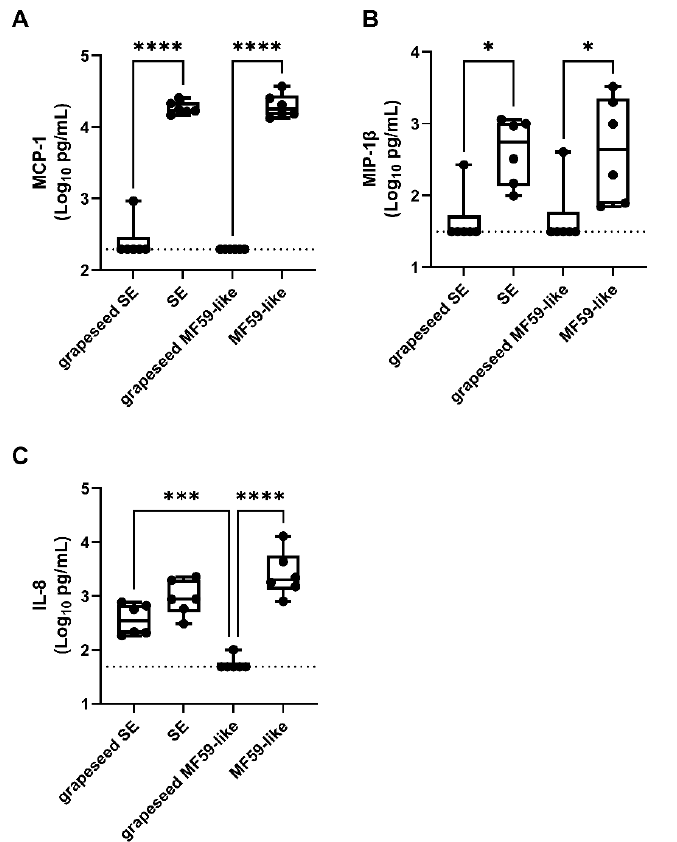
Figure 4. Human whole blood response to emulsion formulations is dominated by oil-phase com- ponent. In vitro stimulation of human whole blood with oil-in-water emulsions at 0.4% v / v oil. Squalene-containing formulations led to increased secretion of ( A ) MCP-1, ( B ) MIP-1 β , and ( C ) IL-8. Log-transformed cytokine concentrations were measured in supernatants of heparinized blood stimulated by incubation with emulsions. Box and whisker plots indicate 1st–3rd quartiles with whiskers representing the minimum and maximum values from n = 6 donors (3 male and 3 female). Statistical significance was determined by one-way ANOVA followed by Tukey’s correction for multiple com- parisons. * p < 0.05, *** p < 0.001, and **** p < 0.0001.